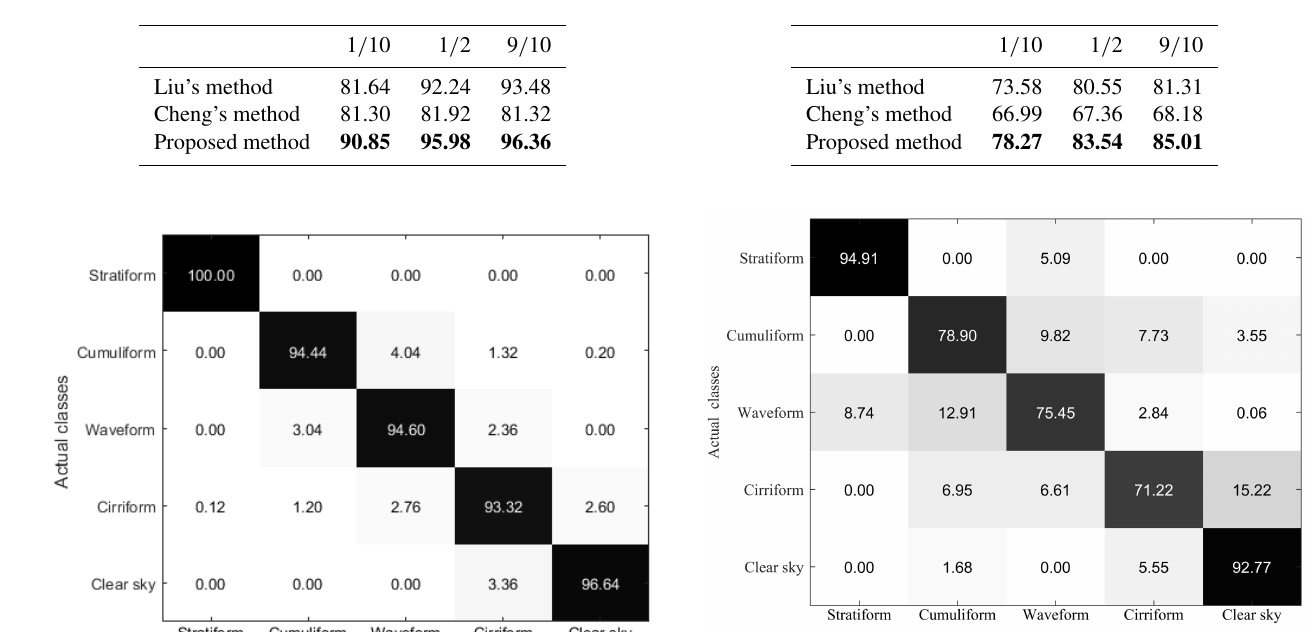
Table 4. The overall classification accuracy (%) on the zenithal dataset. 1 / 10, 1 / 2 and 9 / 10 are the certain proportions of the train- ing set selected randomly from each category, and the rest corre- spondingly forms the testing set. The best results are labelled in bold font.